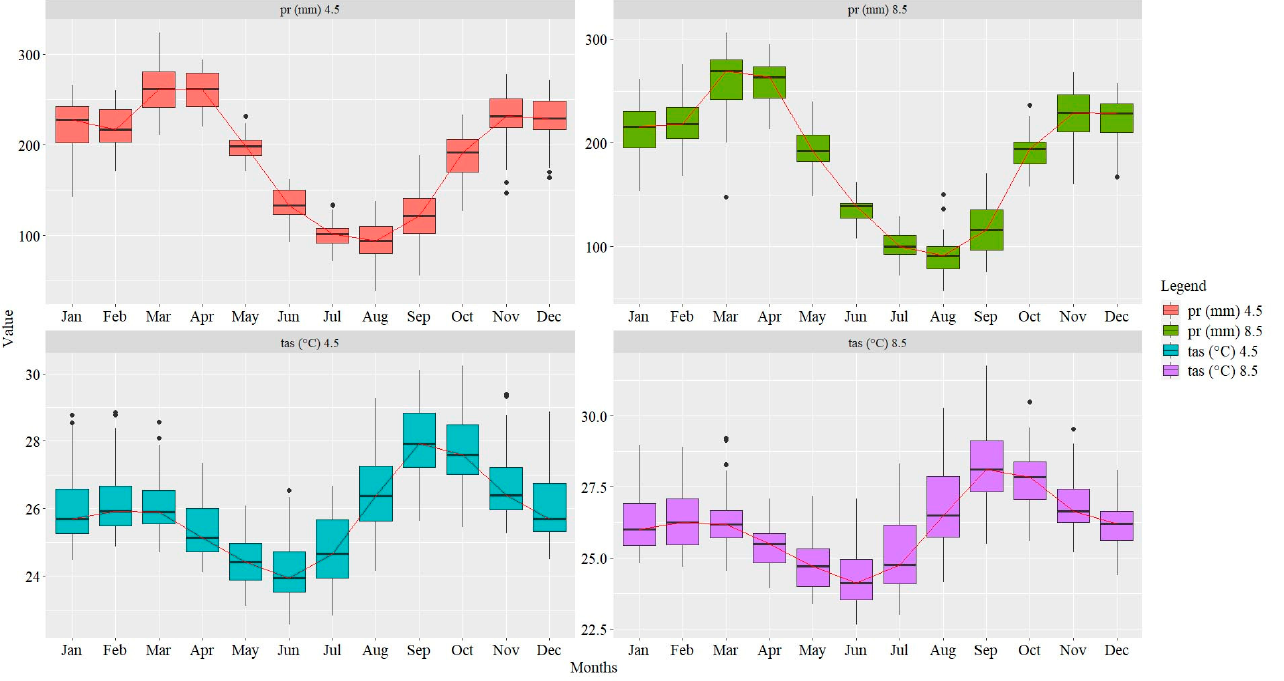
Figure 7. Boxplot statistical analysis for precipitation (pr; mm) and air temperature (tas; °C) for future scenarios SSP2-4.5 ( left column) and SSP5-8.5 ( right column) of CMIP6 on a monthly scale for the 2015–2050 time series.